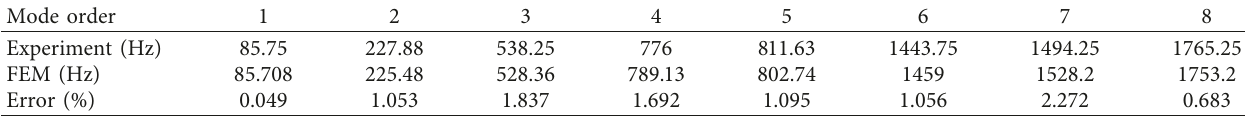
Table 3: Natural frequencies of the bare plate.